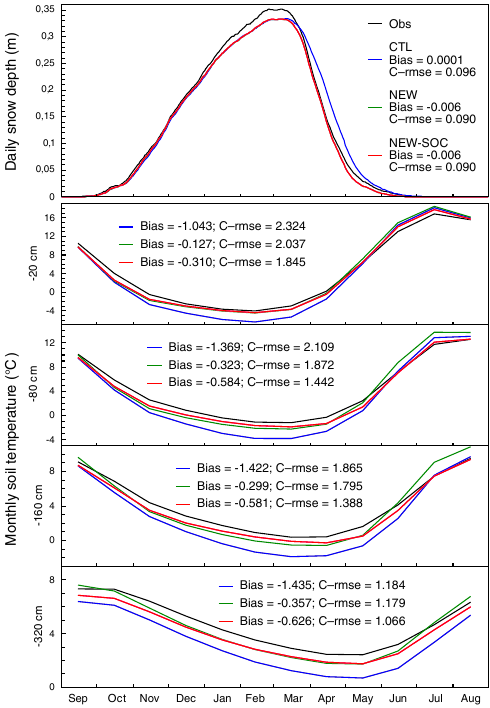
Figure 8. Mean annual cycles of observed and simulated daily snow depth and monthly soil temperature profiles. The mean cycles are computed by averaging all simulated or observed mean annual cy- cles at each station. However, total skill scores (bias and c-rmse) found in each panel are computed by merging together all simu- lated or observed time series of all stations over the entire observed